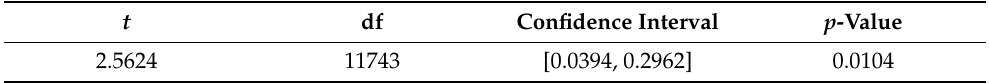
Table 5. Welch two sample t -test between energy production at agrivoltaic and non-agrivoltaic plots. t